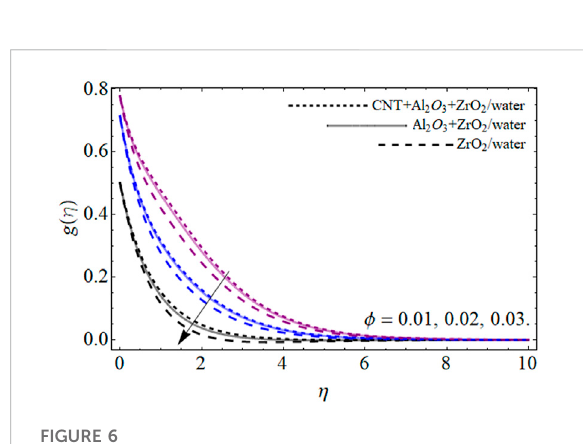
FIGURE 6 Velocity outlines g ( η ) versus ternary nanoparticles ϕ